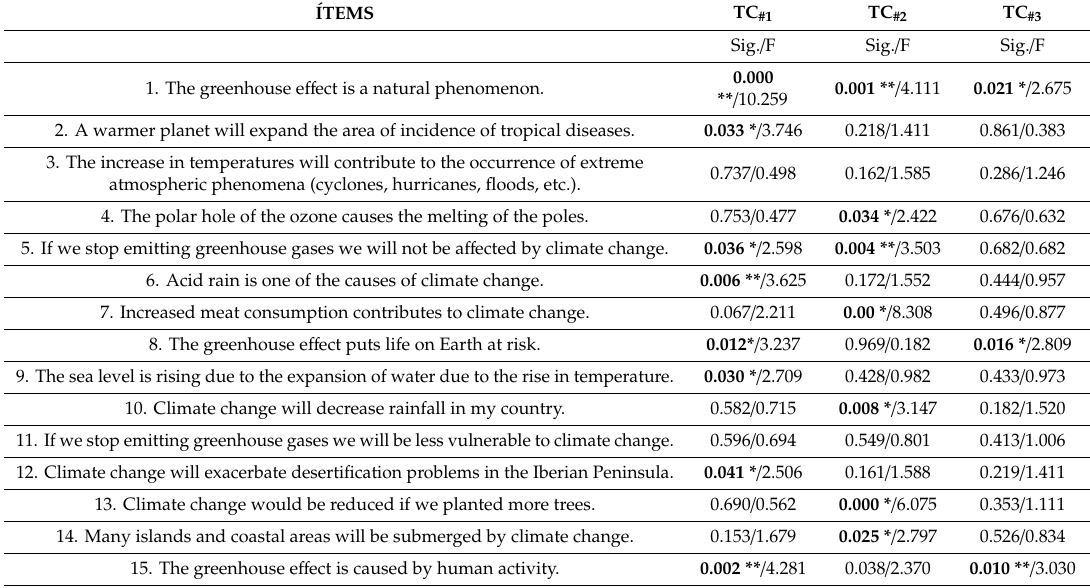
Table 14. Assesses the degree of information received on CC in your degree.